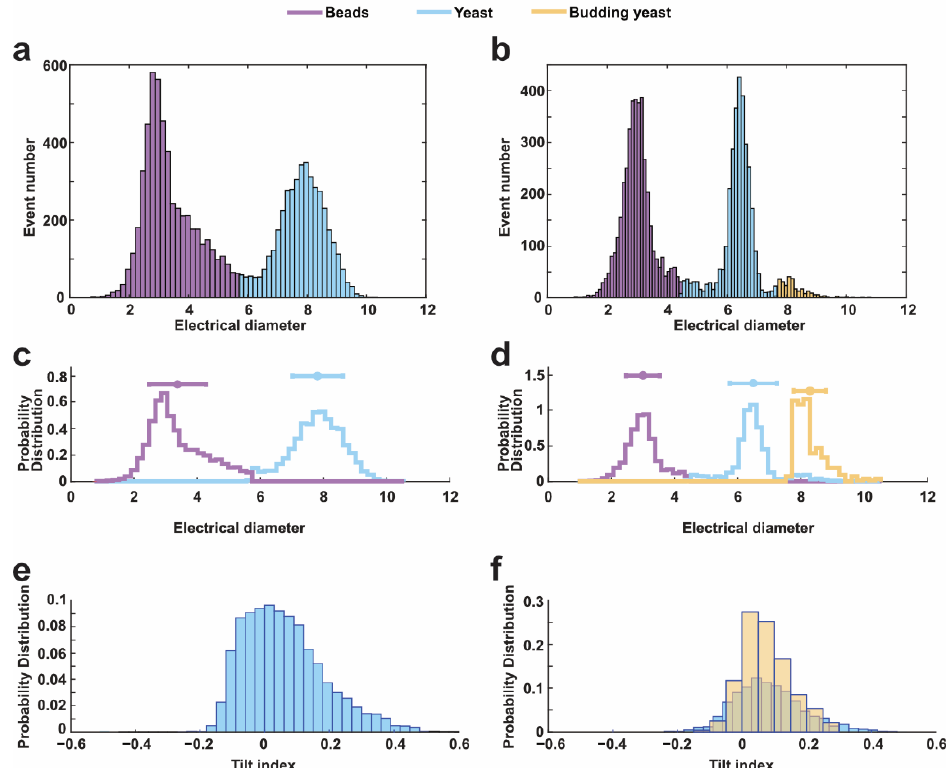
Figure 4. Dielectric properties of yeast cells when using different electrode spans for measurement, 3 µm beads were employed as the reference for calibration. ( a , b ) Distribution of electrical diameter signals of detected beads and cells in suspension when measuring with ( a ) 5 µm and ( b ) 1 µm electrode span. ( c , d ) The discrimination of reference beads and cells using the single-peak gaussian model, based on their electrical diameters obtained with ( a ) 5 µm and ( b ) 1 µm electrode span. ( e , f ) Probability distribution of the tilt index of impedance pulses obtained from electrodes with ( e ) 5 µm gap and ( f ) 1 µm gap.